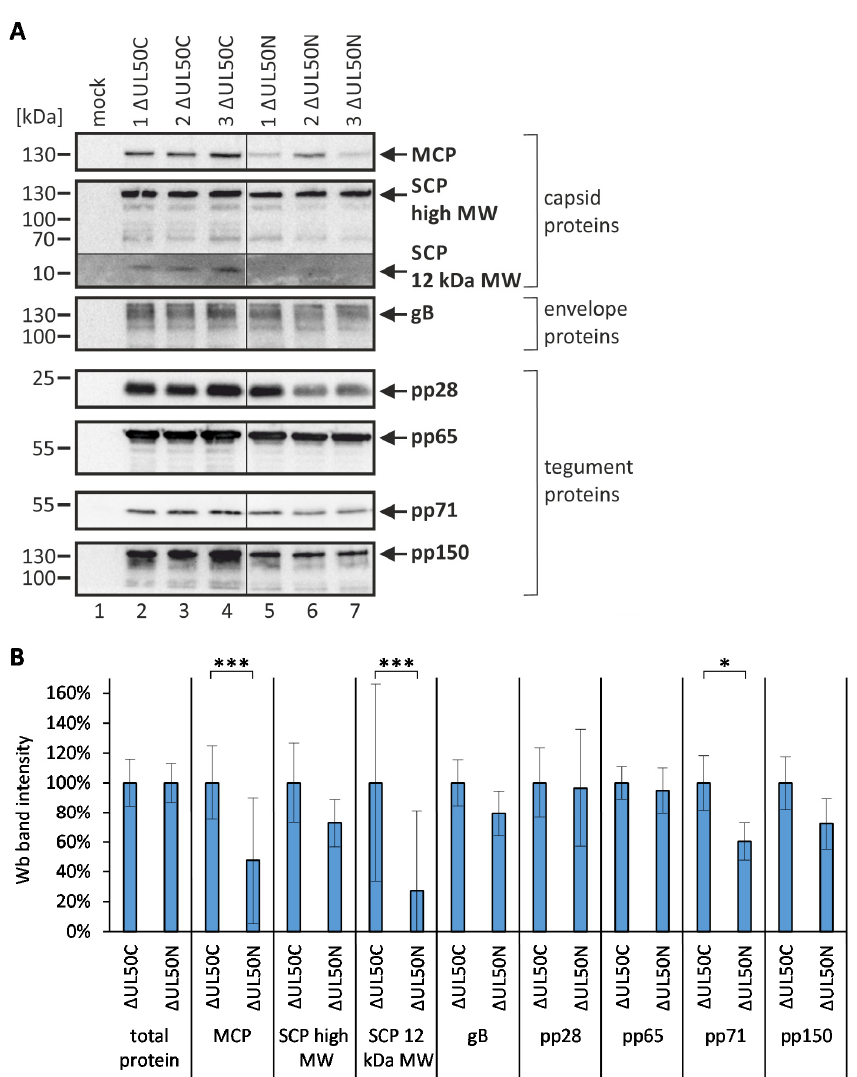
Figure 4. Use of Wb detection as the basis for an initial analysis of the protein composition of Δ UL50C and Δ UL50N particles. ( A ) Wb analysis of Δ UL50C and Δ UL50N particles, adjusted to 5 µg each, immunostained against viral capsid, envelope, and tegument proteins. ( B ) Densitometry- based quantitation, measurements in duplicate, of Wb band intensities using two independent Wb membranes in each case. Total protein was calculated as the sum of densitometry signals for all proteins determined. Mean values ± SD are given, and significance was calculated by the Student’s t -test (*, p ≤ 0.05; ***, p ≤ 0.001).